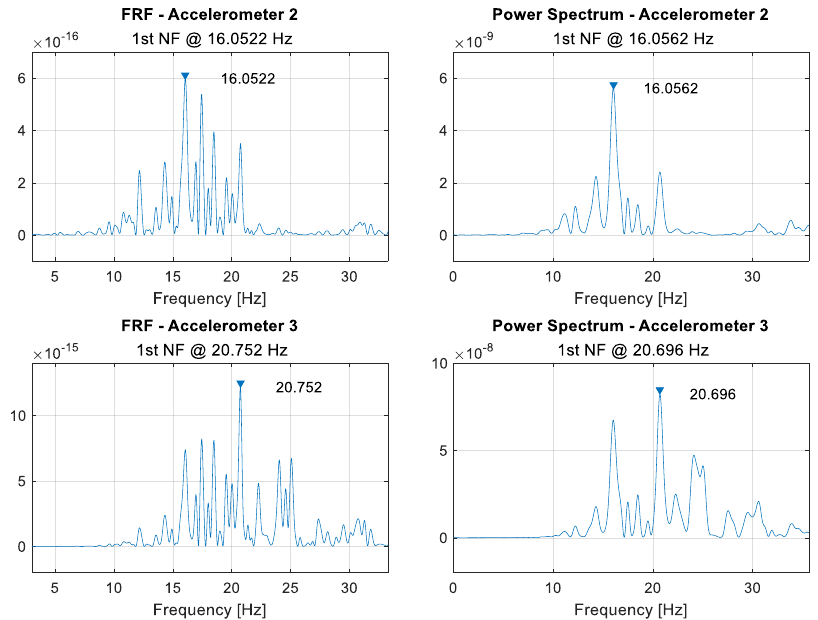
Figure A11. Arduino measurement: 2.0 revolution bolt release.